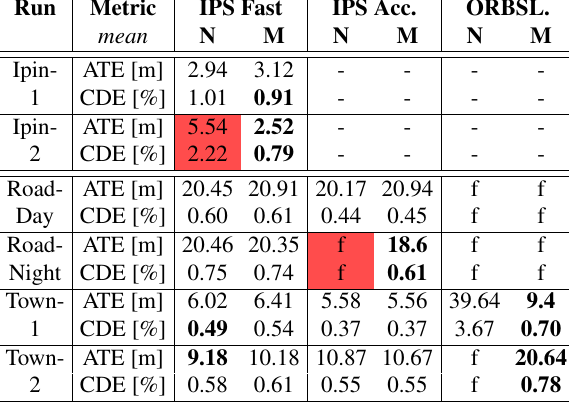
Table 3. Results for IPIN- and NZ-Road Datasets for the individual method without (N) and with (M) using a mask. Bolt numbers mark noticeable relative differences between (N) and (M) of at least 10 %. Particularities are marked with red background. If a result is not given, the method was either Figure 6. System- and localization parameters in local considered as failed (f) or was not applied (-). coordinates of IPS Fast ( Masked ) on an escalator of run Ipin-2 . the IMU measures the walking motion profile and only meas- ures the gravity during the ride. Second, the estimated normal- ized relative translation of the VO is shown. While the relative translation should be constantly high, IPS Fast VO frequently estimates zero-movement due to a high number of detected fea- tures on the person, as shown in Figure 1 (a). Using these